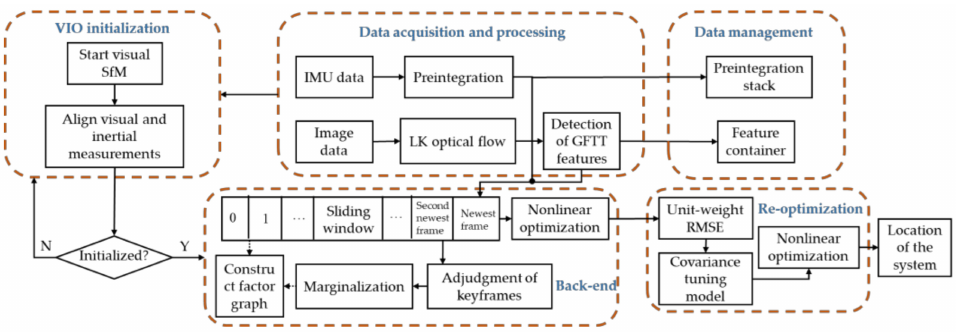
Figure 1. Architecture of the resilient covariance tuning-based visual–inertial fusion